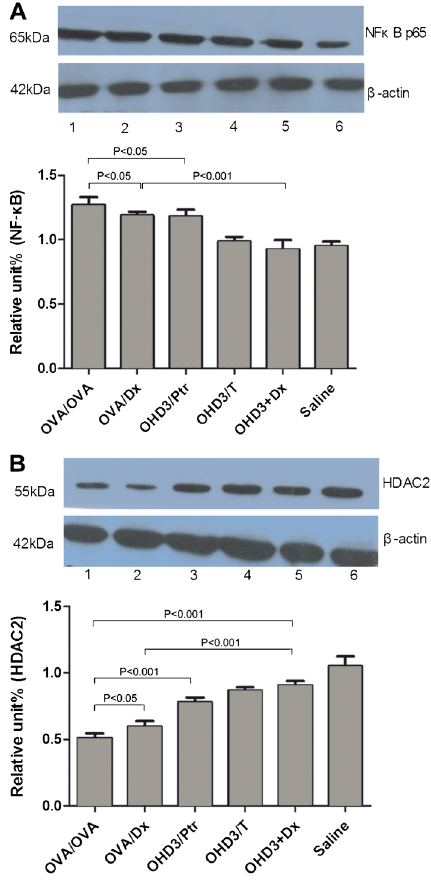
Figure 5. Effect of different treatments on nuclear factor kappa B (NF- k B) p65 and histone deacetylase 2 (HDAC2) protein expression in the lung tissues. A , Effect of different treatments on NF- k B p65 protein expression. A representative Western blot is shown in the upper panel and the analysis of the ratio between NF- k B and b -actin by densitometry is shown in the lower panel. The relative NF- k B p65 protein levels were higher in the OVA/ OVA group than that in the saline controls (P , 0.001), but such increase was significantly attenuated in rats pretreated or treated with 1,25(OH) 2 D 3 (P , 0.05). The combined treatment with 1,25(OH) 2 D 3 and dexamethasone further decreased NF- k B p65 to that of the saline control group (P , 0.001; A ). B , Effect of different treatments on HDAC2 protein expression in the lung tissues. A representative Western blot is shown in the upper panel and the analysis of the ratio between HDAC2 and b -actin by densitomitry is shown in the lower panel. The relative HDAC2 protein levels were decreased significantly in the OVA/OVA group compared to the saline controls (P , 0.001), but such decrease was decreased significantly in the animals pretreated or treated with 1,25(OH) 2 D 3 (P , 0.05). Lanes in Western blots: 1 , OVA/OVA (asthma group); 2 , OVA/Dx (dexamethasone treated group); 3 , OHD3/Ptr (1,25(OH) 2 D 3 pretreatment group); 4 , OHD3/T (1,25(OH) 2 D 3 treated group); 5 , OHD3++Dx (dexa- methasone and 1,25(OH) 2 D 3 treated group); 6 , saline (negative control group). ANOVA and Student-Newman-Keuls tests were used for statistical